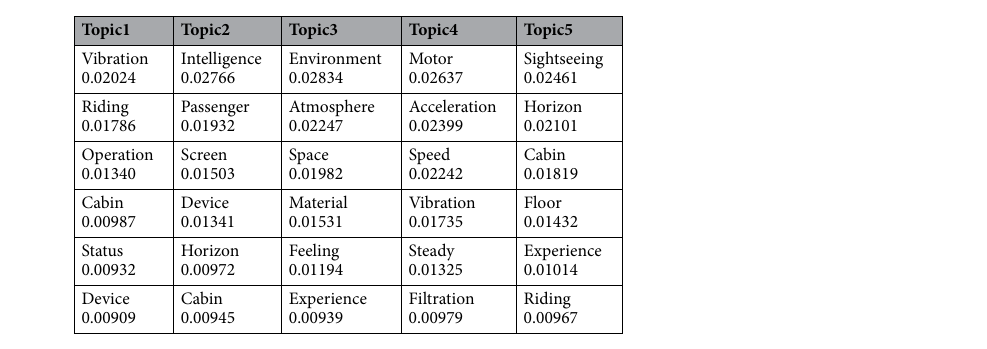
Table 3. Five kinds of functional